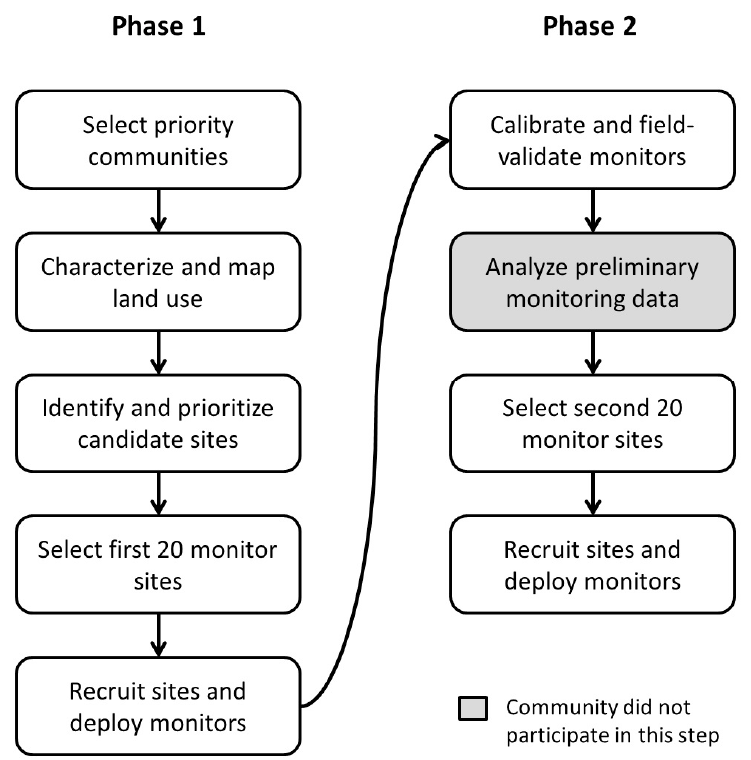
Figure 1. Diagram of the participatory process to site monitors.